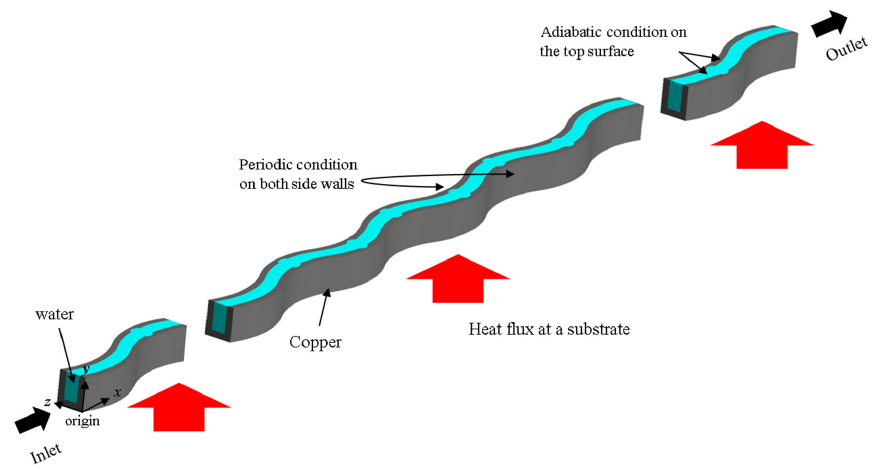
Figure 2. Boundary conditions.